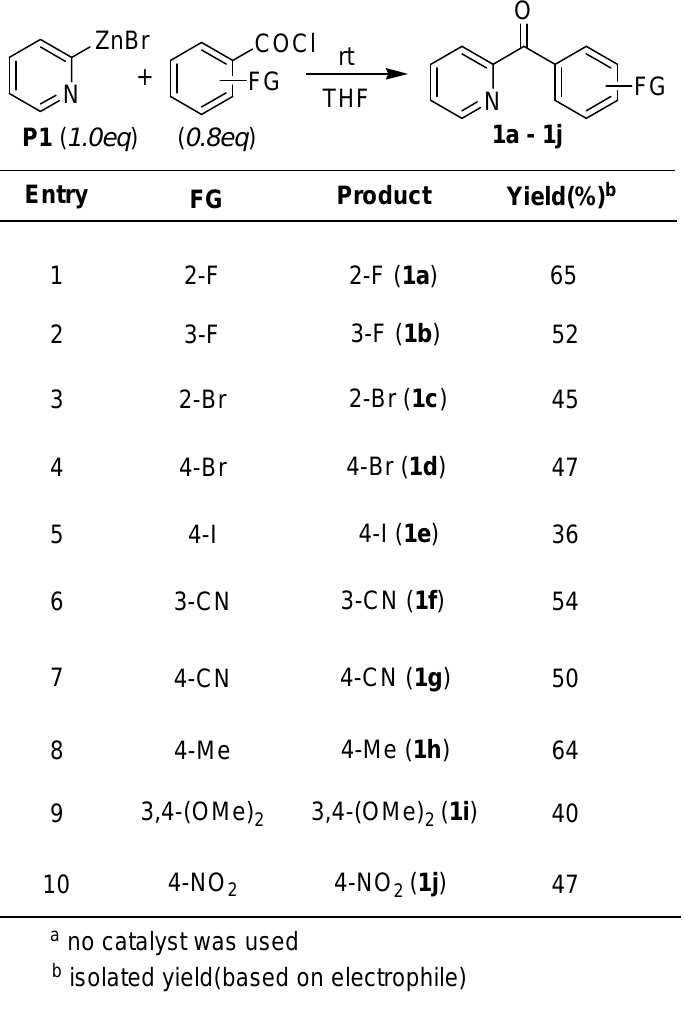
Table 1. Coupling reaction with benzoyl chlorides.